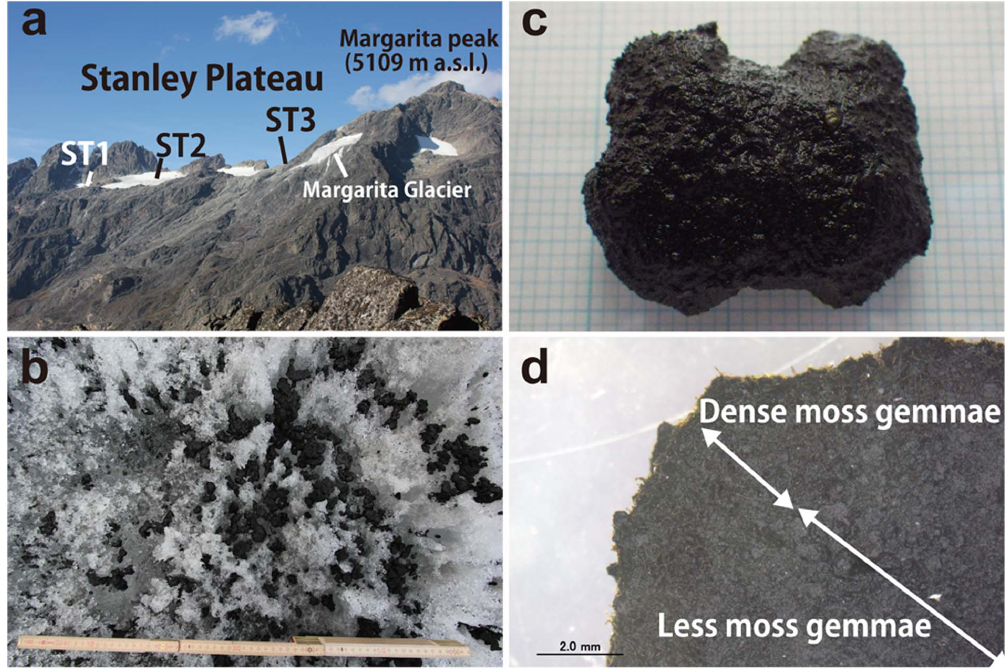
Figure 2. Research site and glacier moss gemmae aggregation (GMGA). a) Stanley Plateau glacier and Margarita Peak from Mt. Baker, b) Glacier ice surface covered by GMGAs, c) GMGAs (grid cells beneath GMGA are 1 6 1 mm), d) Cross section of GMGA (scale bar: 2 mm).